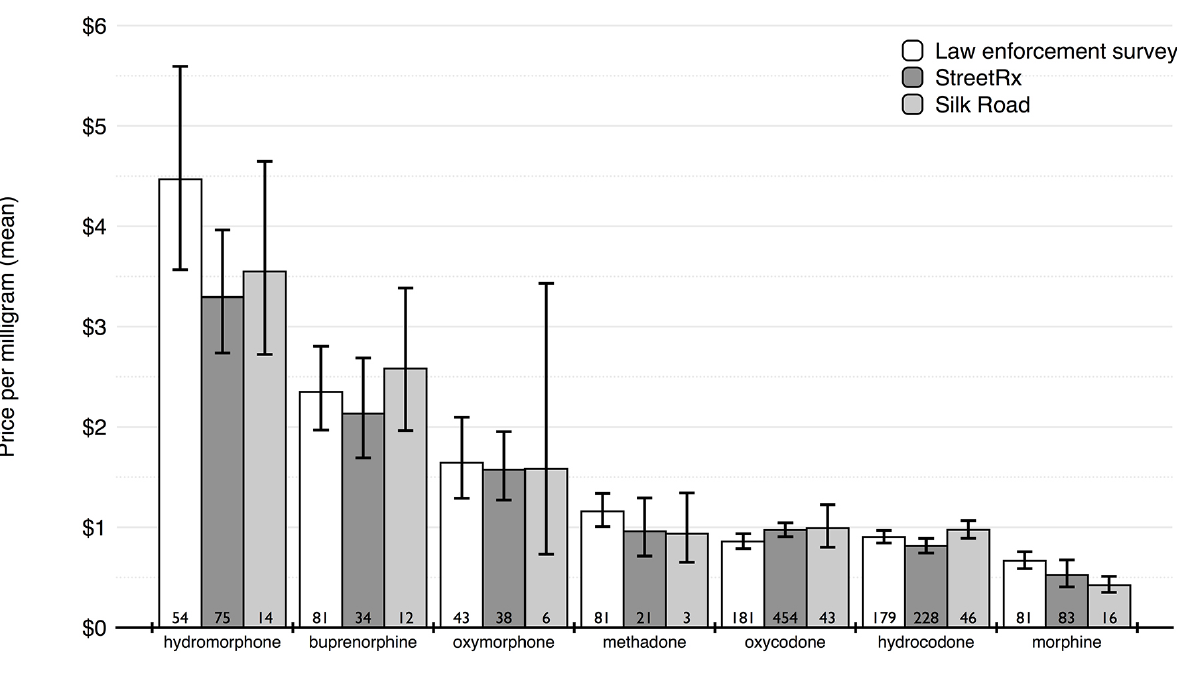
Figure 4. Mean price per milligram of each opioid analgesic, between the data sources. Numbers at the bottom of each bar indicate sample